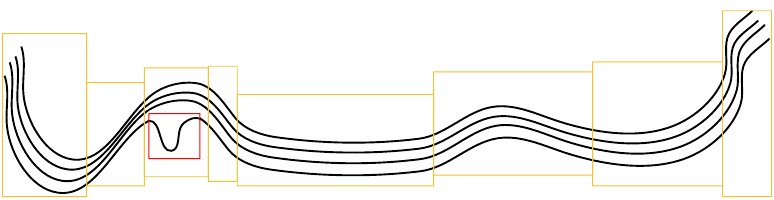
Figure 1. A short local anomaly in a